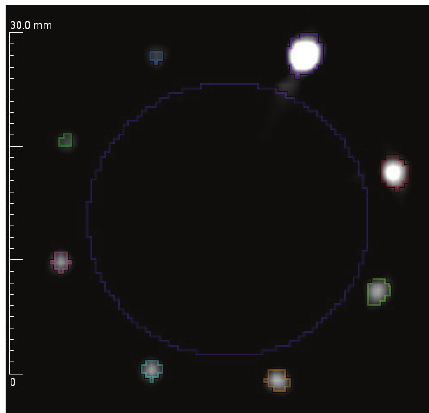
Figure 12: Contrast to noise ratio ROI measurement locations (grayscale in